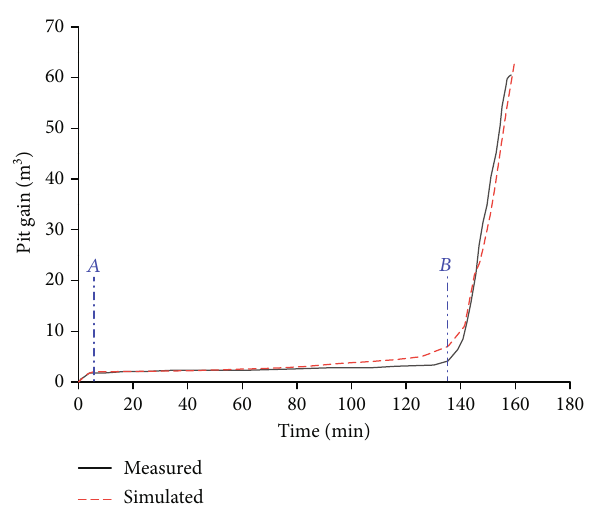
Figure 2: Comparison between measured and simulated pit gains during CO 2